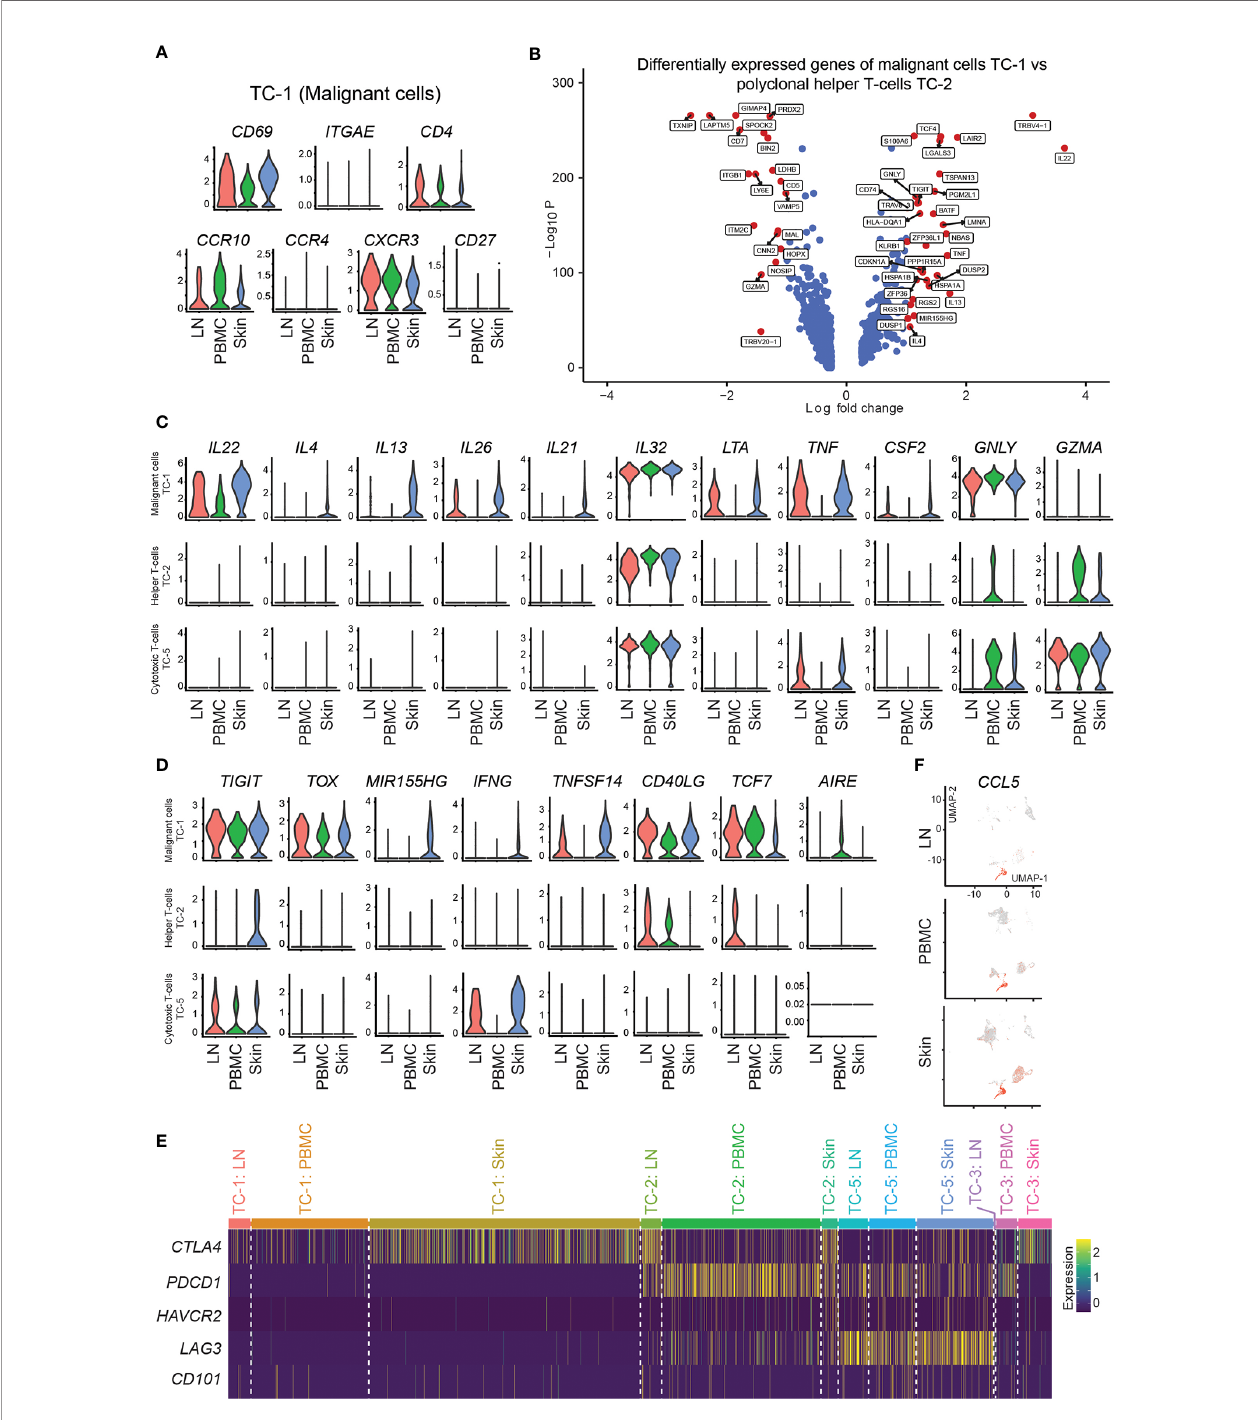
FIGURE 4 | Marker expression of malignant and benign T-cells. (A) Violin plots of T-cells in cluster TC-1 showing distribution of normalized gene expression levels of the respective genes in lymph node (red), blood (green) and skin samples (blue). (B) Volcano plot of differentially express genes between T-cells in malignant cluster TC-1 and benign T-helper cell cluster TC-2 combining all samples as calculated by Wilcoxon Rank Sum Test and Bonferroni correction. Genes with log fold change >|1.0| are labeled in red. (C, D) Violin plots of TC-1 (clonally expanded tumor cells), TC-2 (benign helper T-cells) and TC-5 (benign CD8+ cytotoxic T-cells) showing the distribution of normalized gene expression levels of the respective genes in lymph node (red), blood (green) and skin samples (blue). (E) Expression heat map of selected checkpoint molecules. Upregulation is indicated in yellow, downregulation in purple. (F) Feature plots of CCL5 (RANTES). Normalized expression levels for each cell are color-coded (red) and overlaid onto separate UMAP plots for lymph node (LN), blood (PBMC) and skin. Intensity red color re fl ects respective level of